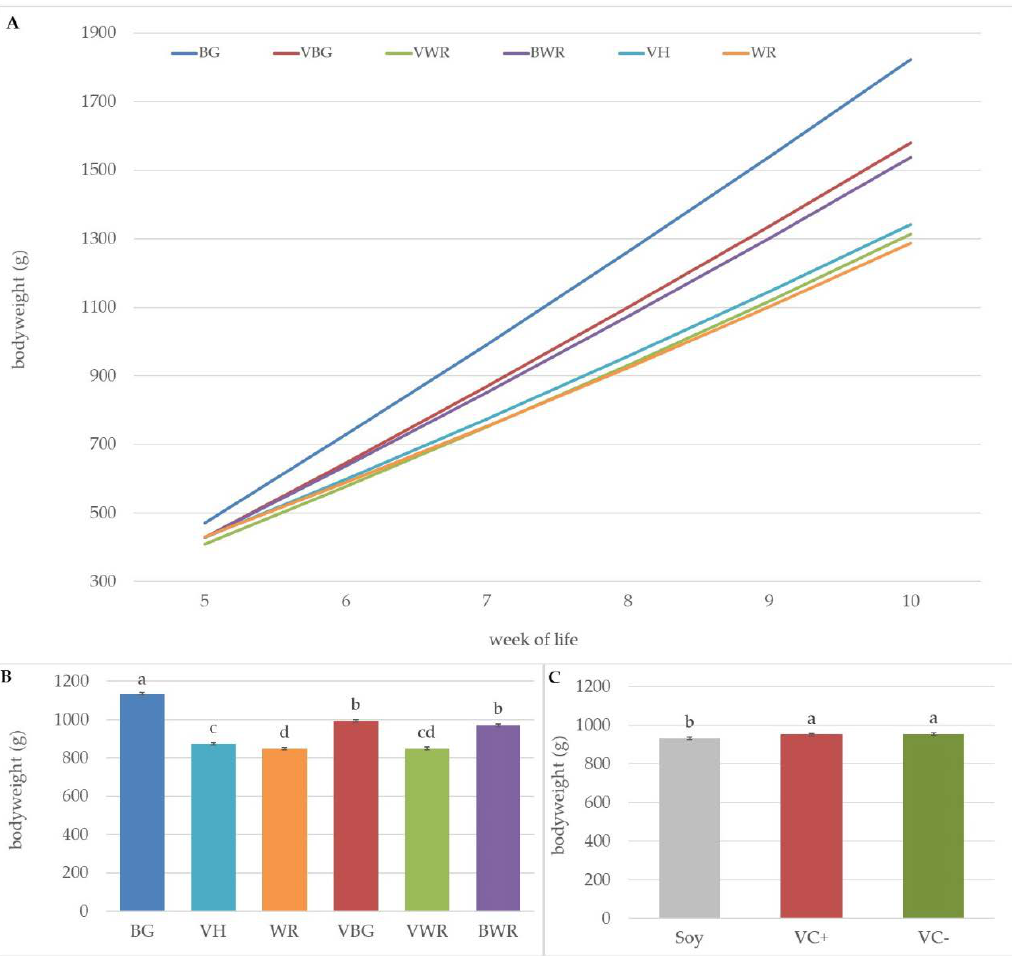
Figure 3. Comparison of the genotypes from week of life five to ten. ( A ) Effect of genotype on weight development. ( B ) LS-means ± SE for bodyweight of the respective genotypes adjusted by the mean of age. ( C ) LS-means ± SE for bodyweight of the different feeding groups adjusted by the mean of age. a,b,c,d Genotypes not sharing a letter differ at p < 0.05.